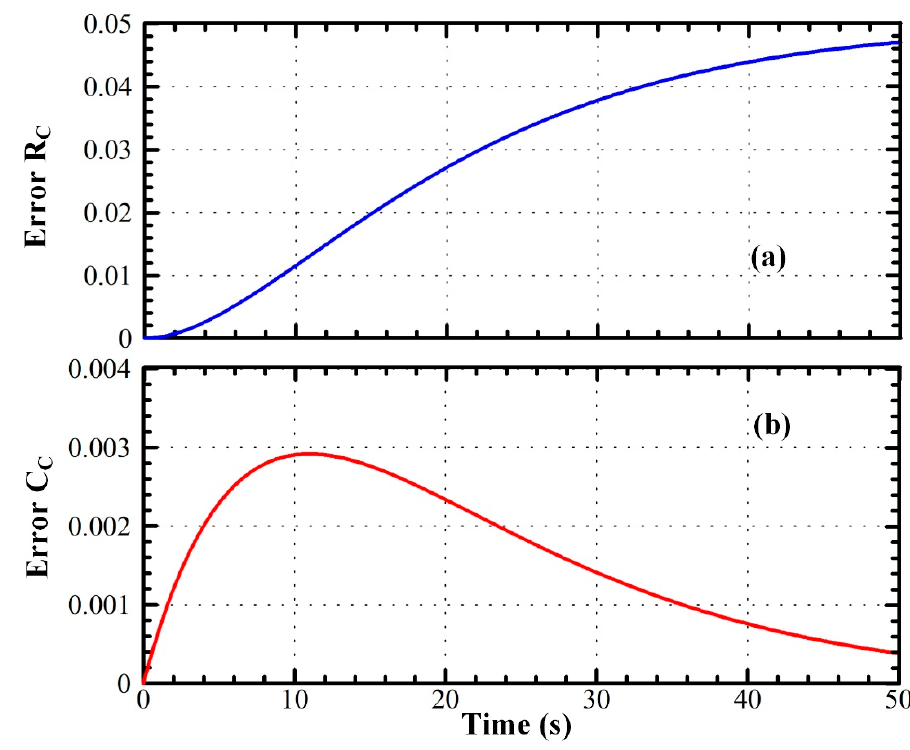
Figure 8. Error due to the cathode resistance ( a ) and due to the cathode capacitance ( b ).